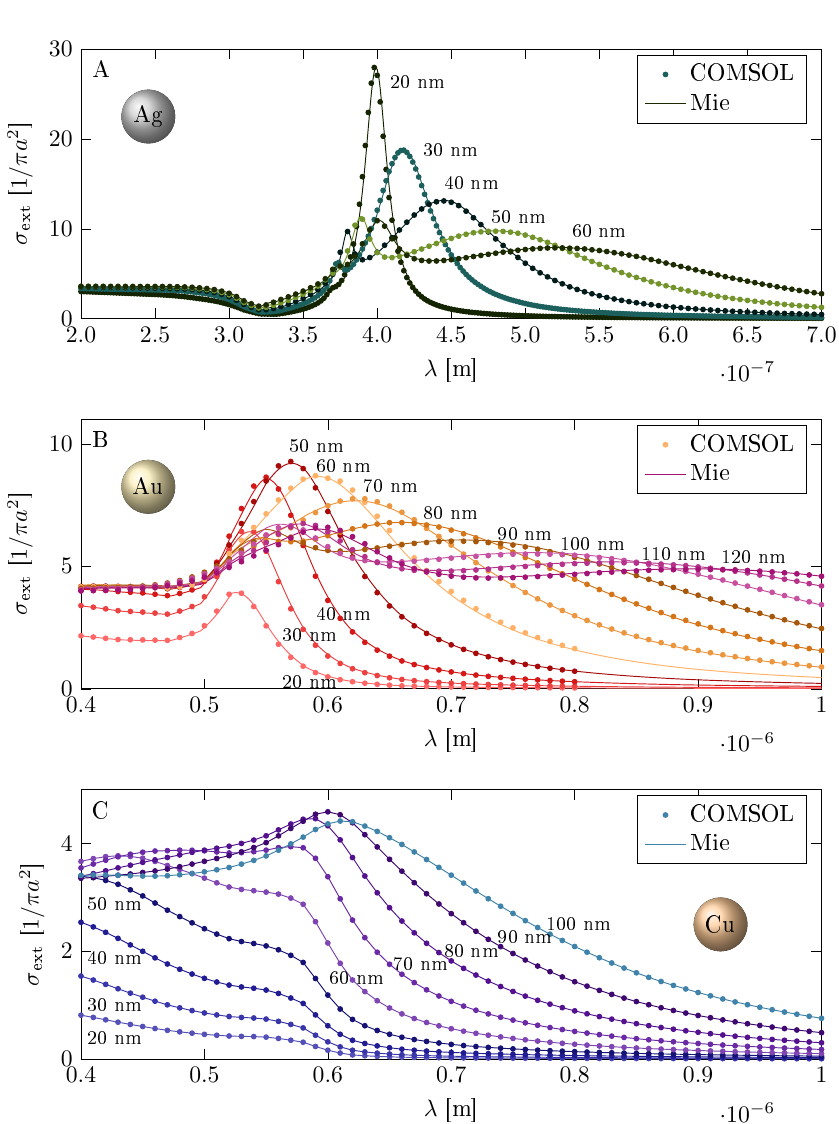
Figure 2. Surface plasmon resonances (extinction cross-section σ ext ( λ ) spectral dependence) for Au ( A ), Ag ( B ) and Cu ( C ) spherical nanoparticles with various radii. The dominating peak corresponding to the dipole plasmon mode at the radii region a (10–100) nm overlaps very well with the visible part ∈ of the sun-light spectrum, which is convenient for plasmon-photovoltaic